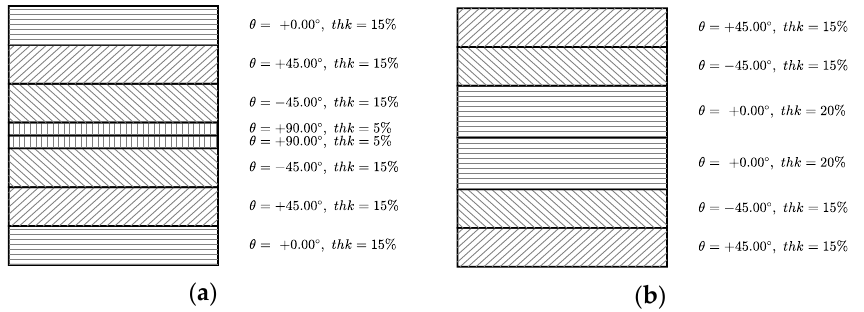
Figure 9. The two stacking sequences used with the percentual thickness (thk) of each ply: ( a ) LAM1; ( b ) LAM2. Table 5. Carbon Fiber Uni ‐ Directional (CFUD) properties from [48].